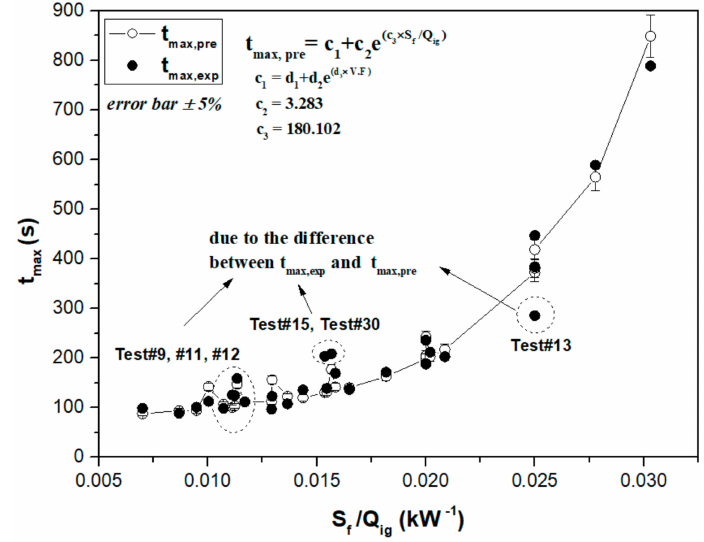
Figure 12. Comparison of the maximum time of experiments and predictions with S f / Q